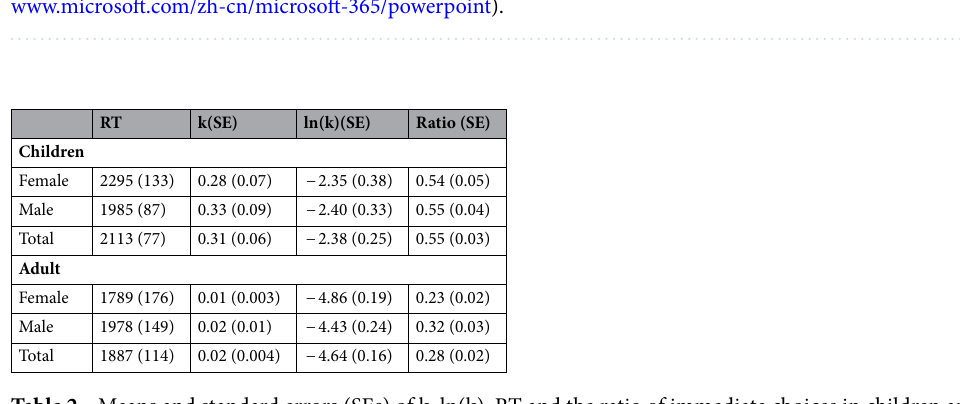
Table 2. Means and standard errors (SEs) of k, ln(k), RT and the ratio of immediate choices in children and adults.